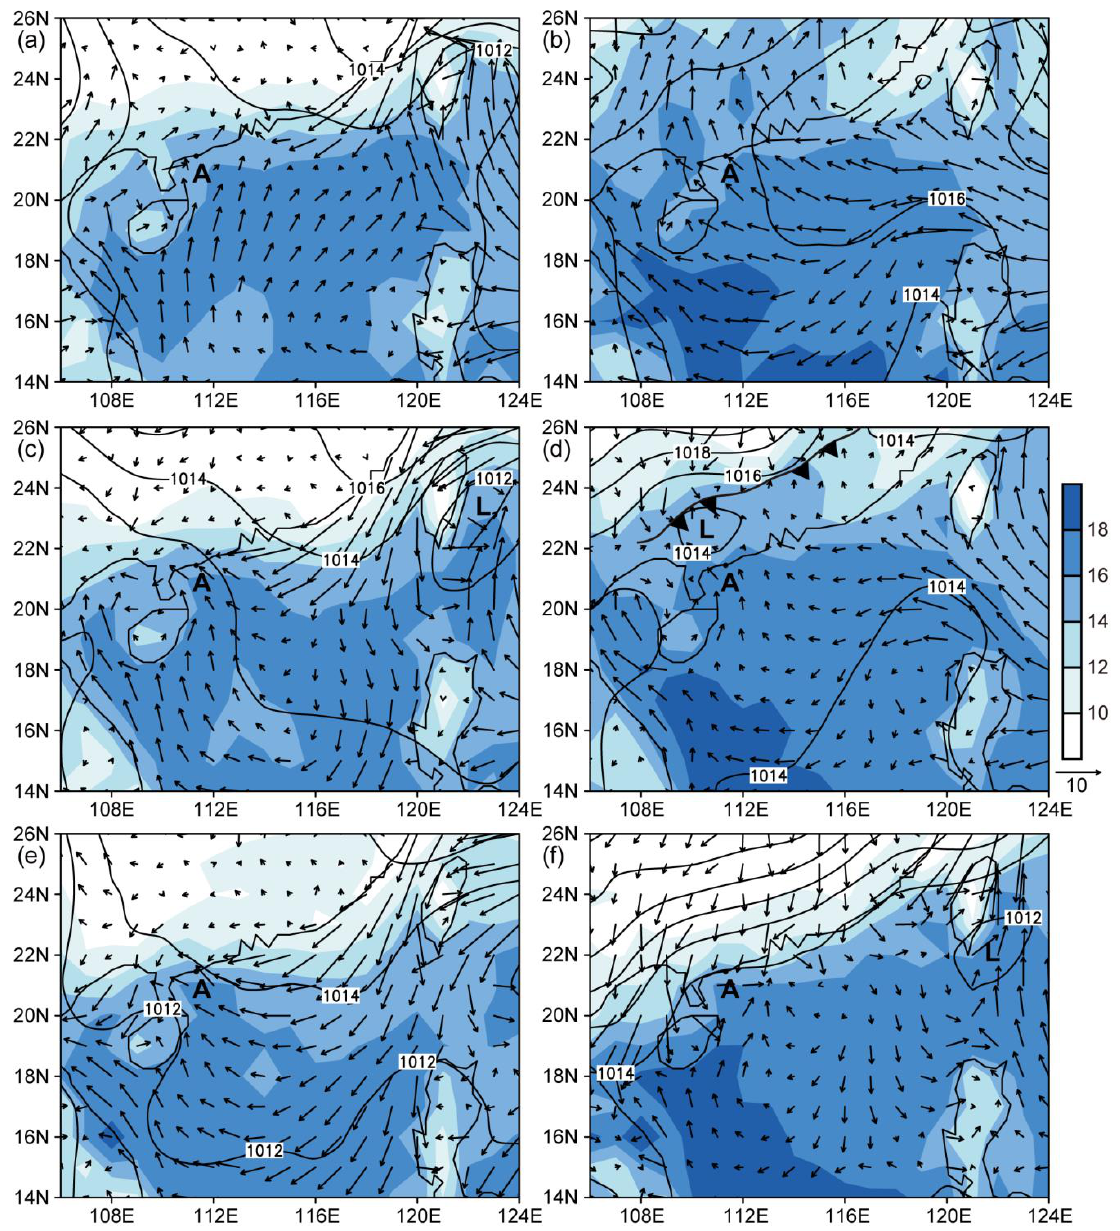
Figure 2. Wind vectors (m s − 1 ), water-vapor mixing ratio (shaded, g kg − 1 ), and air pressure at sea-surface level (hPa). ( a ) 1400 LST March 10. ( b ) 1400 LST Mar 30. ( c ) 0200 LST Mar 11. ( d ) 0200 LST 31 March (with cold-front location). ( e ) 1400 LST March 11. ( f ) 1400 LST 31 March (From the FNL on 1° × 1° grid spacing datasets.). “ A ” is the coastal site.